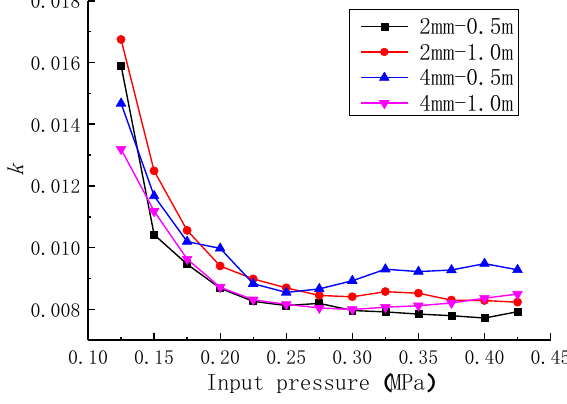
Figure 5. 𝑘 curve. Figure 5. k